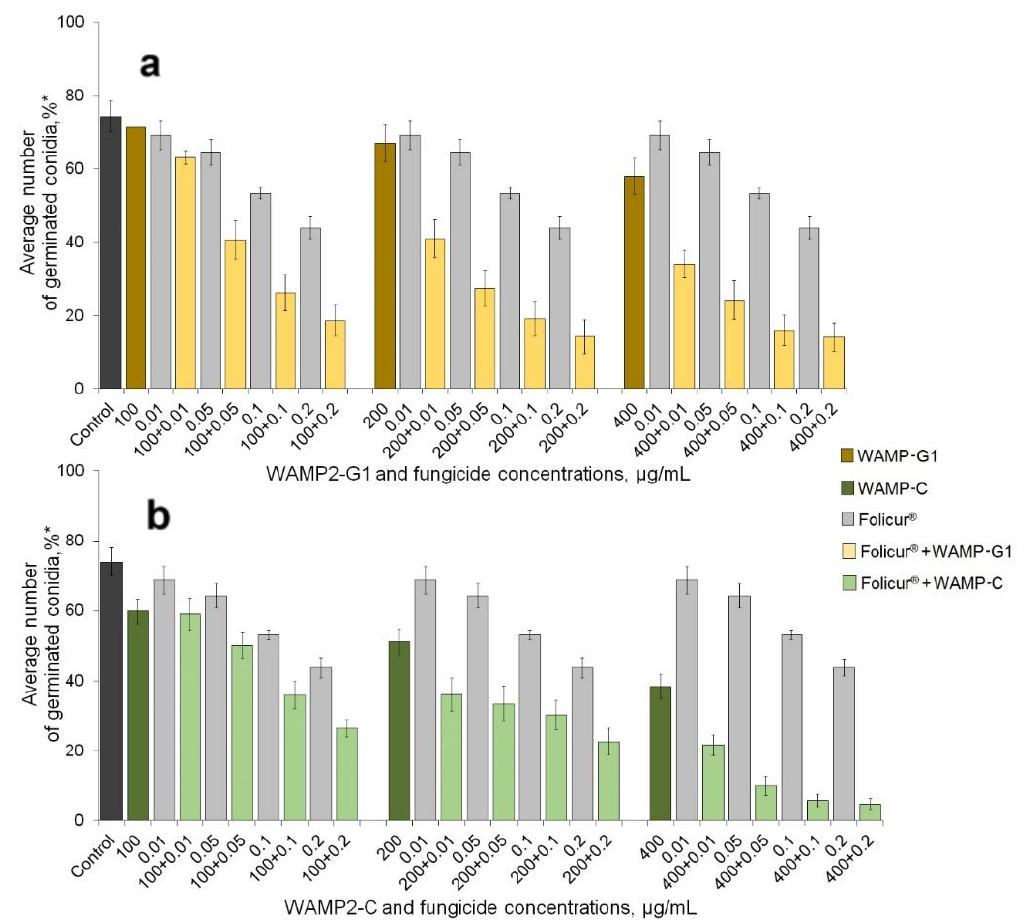
Figure 3. Enhancement of the inhibition of A. solani conidial germination after treatments with Folicur ® , EC 250 combined with ( a ) WAMP-G1, or ( b ) WAMP-C compared to ( a , b ) Folicur ® alone. * Percentage of germinated conidia of the total number of conidia counted. Controls are A. solani conidia germinated in SDW. See also the explanations in the Figure 1 caption.